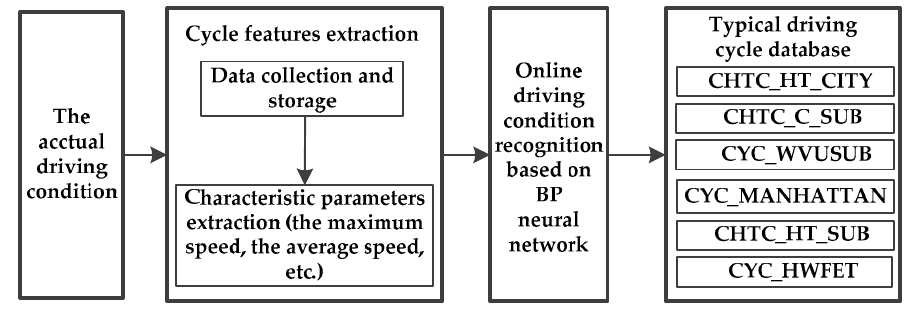
Figure 7. On-line recognition process of driving conditions.